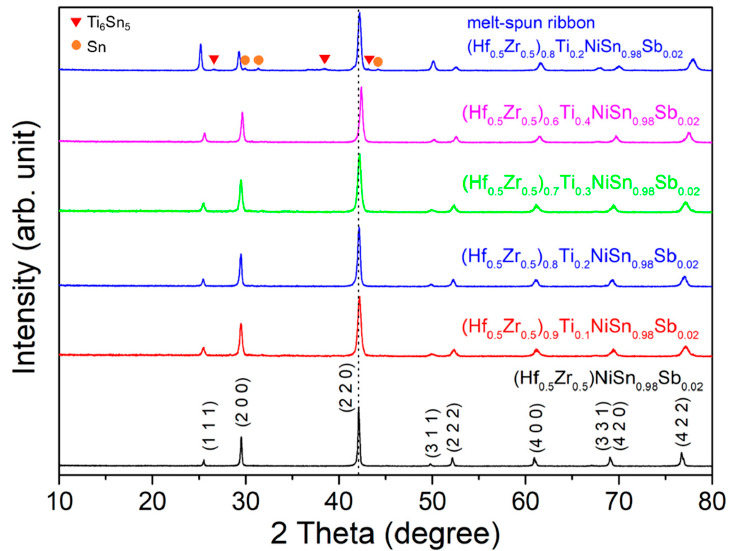
Figure 2. X-ray diffraction (XRD) patterns for the melt-spun ribbons of (Hf 0.5 Zr 0.5 ) 0.8 Ti 0.2 NiSn 0.98 Sb 0.02 and sintered bulks of (Hf 0.5 Zr 0.5 ) 1 − x Ti x NiSn 0.98 Sb 0.02 ( x = 0, 0.1, 0.2, 0.3, and 0.4).